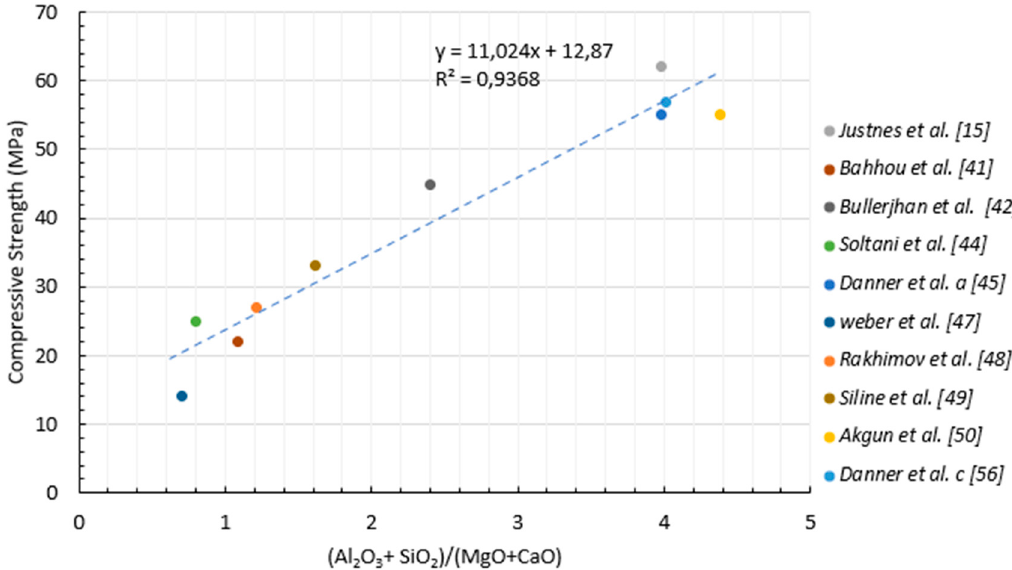
Figure 6. Correlation between the compressive strength and the ratio (Al 2 O 3 + SiO2)/(MgO+CaO). Justnes et al. [15], Bahhou et al. [41], Bullerjhan et al. [42], Soltani et al. [44], Danner et al. a [45], Weber et al. [47], Rakhimov et al. [48], Siline et al. [49], Akgun et al. [50], Danner et al. c [56]. 177 Calcined marl usually promotes long-term development of mechanical performance 178 and durability signs. They are a great reducer of corrosion rate, because with increasing